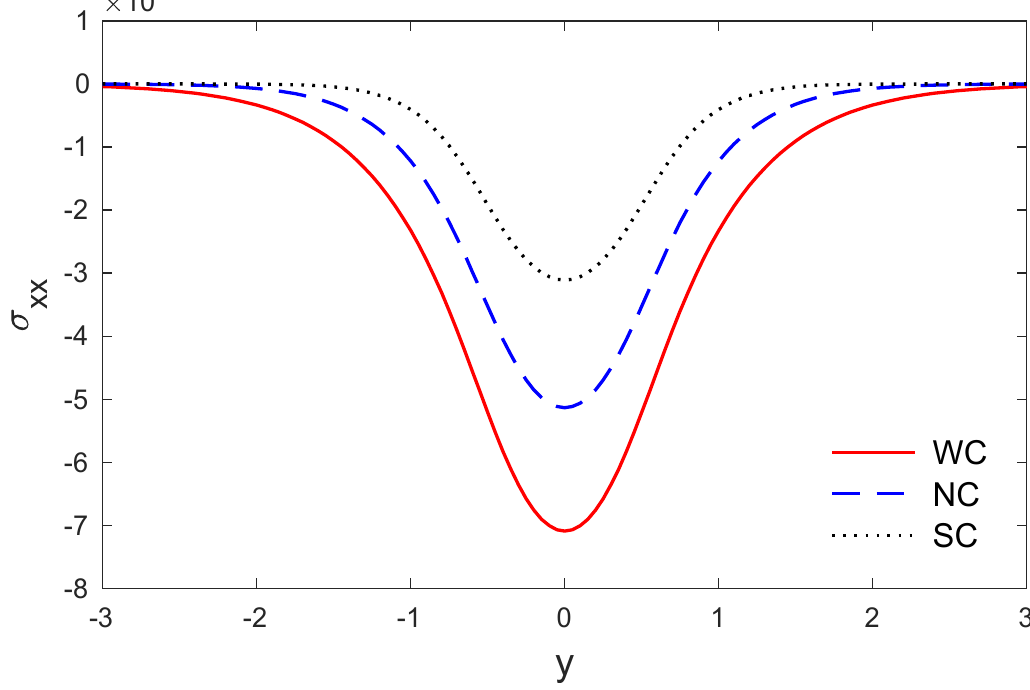
Figure 12. The variation of stresses components σ xx versus y when x = 0.4 for strong normal and weak conductivities.